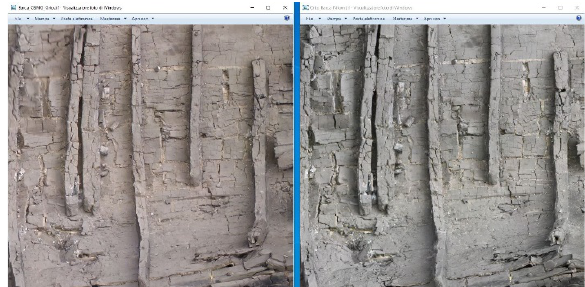
Figure 5. A visual comparison of the ortho-photos extracted by the close-range photogrammetry data. On left the OSMO acquisition and on the right the Nikon one.